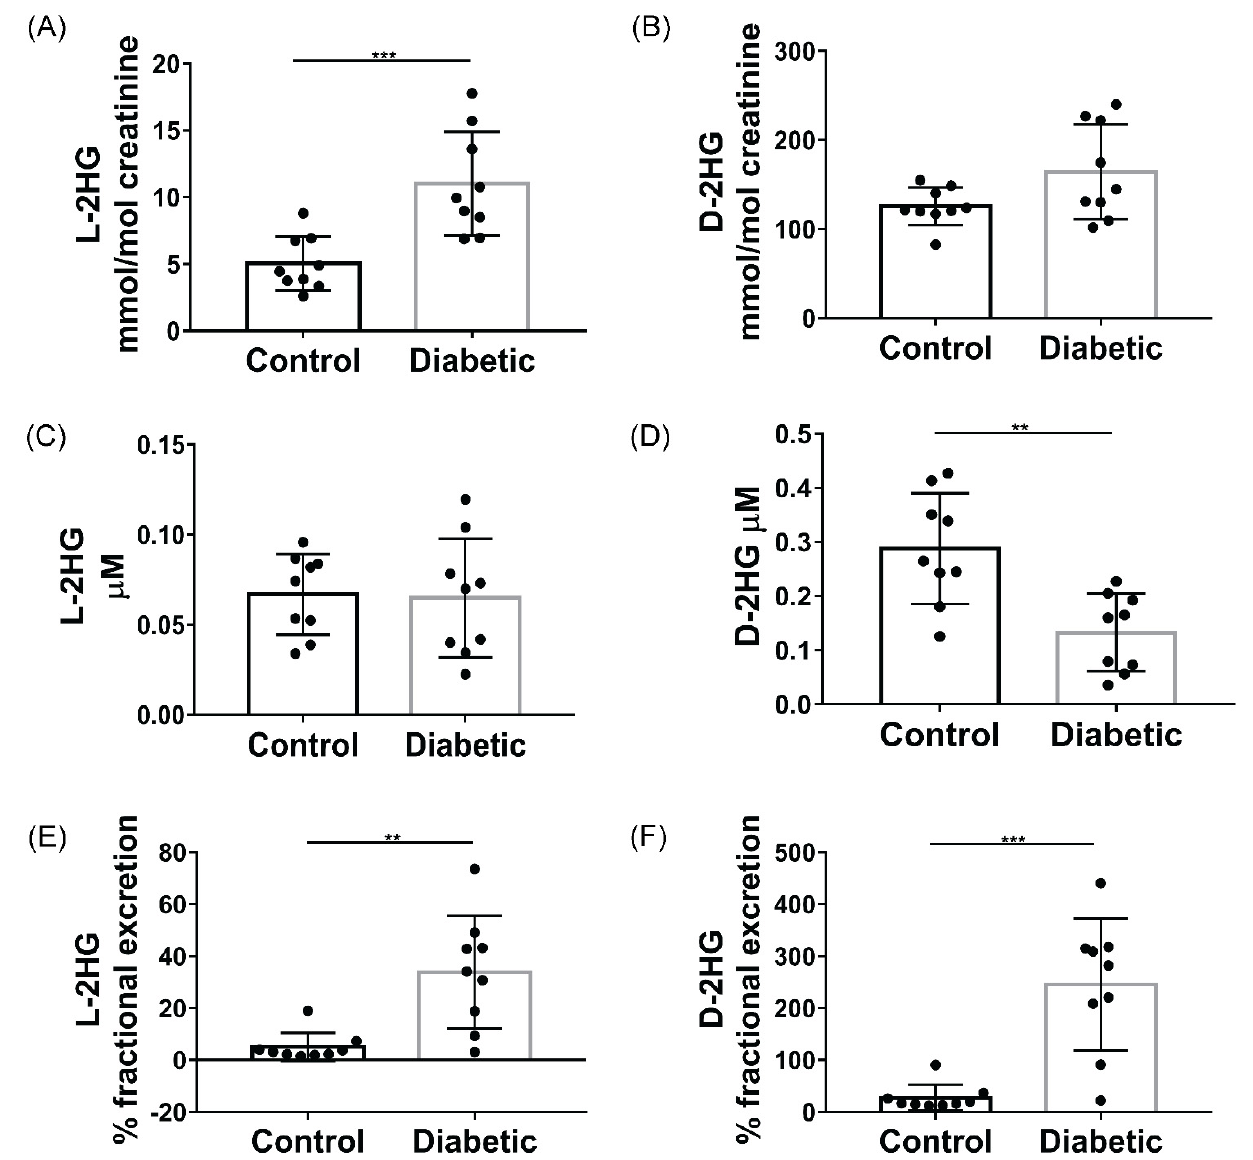
Figure 1. Concentration of L and D-2HG ( ± SD) in plasma and urine and calculated percent fractional excretion of each metabolite from Control ( db / + ) and Diabetic ( db / db ) and mice. ( A ) Urinary L-2HG and ( B ) Urinary D-2HG levels normalized creatinine, ( C ) plasma L-2HG levels, ( D ) plasma D-2HG levels, ( E ) % fractional excretion of L-2HG, ( F ) % fractional excretion of D-2HG. Student’s t -test, ** = p -value ≤ 0.001, *** = p -value ≤ 0.0001.